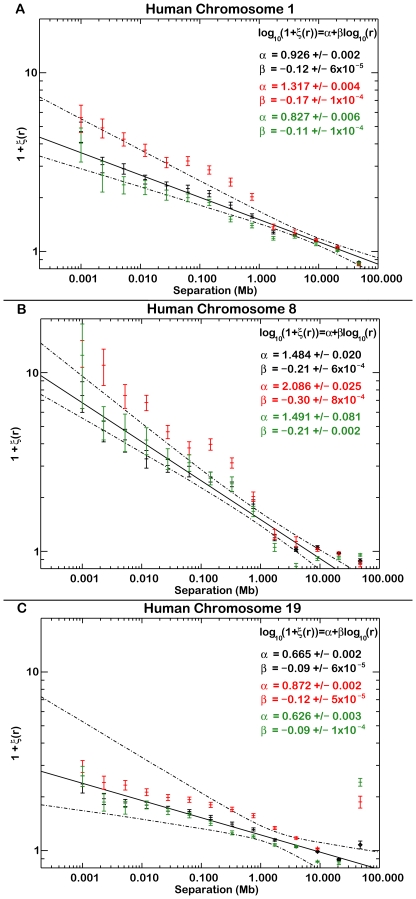
The Two Point Correlation Functions of CGI in Chromosomes 1, 8 and 19.The vertical axis shows value of the two-point correlation function, estimated using the bootstrap mean  (see methods), and error bars are . The expectation in the absence of clustering is . CGI using the Takai and Jones (2002) algorithm are shown in black, as are the best-fit power law models. Dotted lines show an approximate 3σ confidence intervals derived from a Monte Carlo based on the bootstrap estimate of ξ and our estimate of its variance (see Methods). Also shown in red (green) are the TPCF for the CGI given by Irizarry et al [56] (Illingworth et al [40]) and the associated regression coefficients also in red (green). Remaining chromosomes can be found in Text S2.